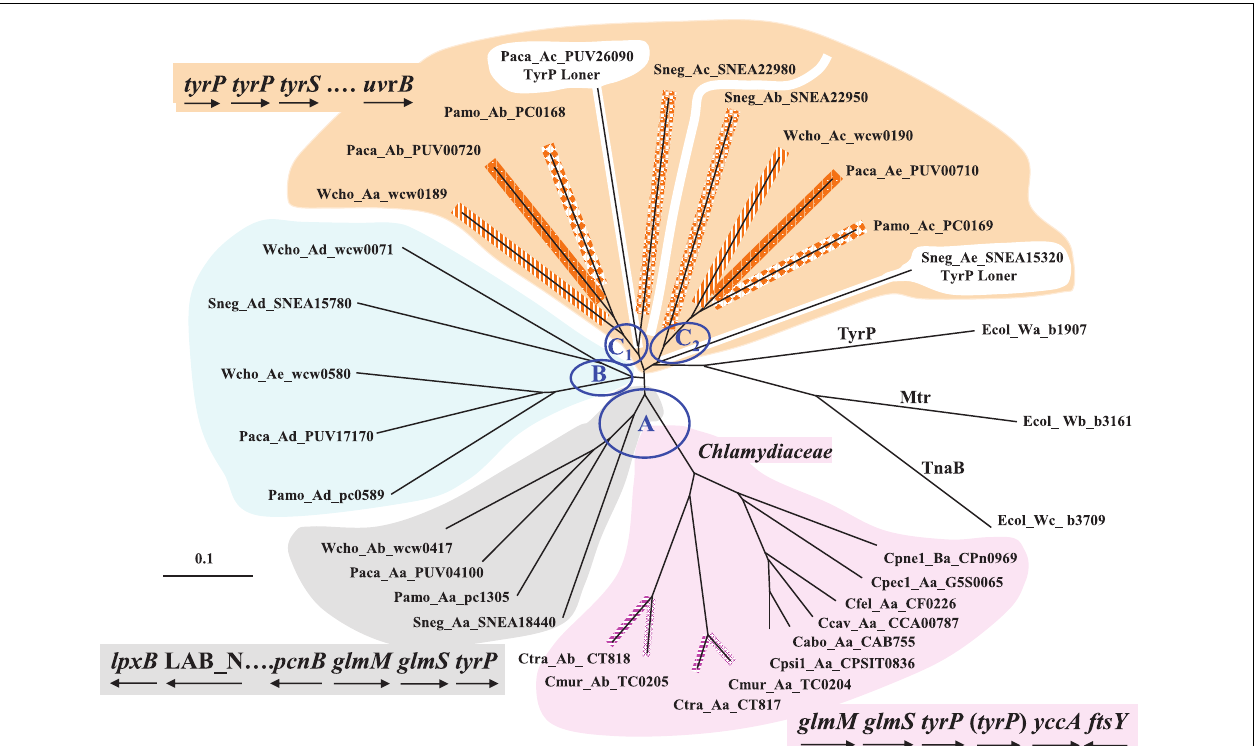
FIGURE 5 | Multiplicity of the TyrP transporter for Trp in the Chlamydiales Order. The three E . coli paralogs for Trp transport are shown at the right. Three main ortholog clusters of TyrP proteins (designated as A–C) are evident, together with an admixture of a few additional paralogs. Cluster A contains one TyrP protein from Wcho, Paca, Pamo, and Sneg – as well as the divergent set of proteins from the Chlamydiaceae . Ctra and Cmur each have two paralogs, which appear to have occurred independently via gene duplications that followed the speciation divergence. At the lower left is shown a suggested ancestral gene neighborhood which can be compared to the Chlamydiaceae gene neighborhood shown at the lower right. In the latter gene neighborhood inclusion of “( tyrP )” is relevant only to the gene duplicate present in the Cmur/Ctra pair. The Chlamydiaceae have no representation in ortholog clusters B and C. Cluster B possesses members from Wcho, Sneg,